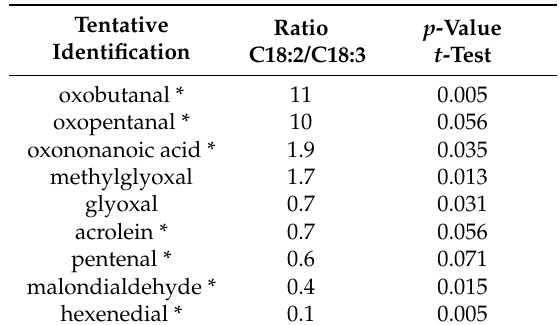
Table 2. Average comparison of selected, tentatively identified carbonyl compounds between the reaction mixtures of linoleic and linolenic acids. Values below one represent candidates that were more abundant in linolenic acid mixtures, and those above one represent candidates preferentially formed from linoleic